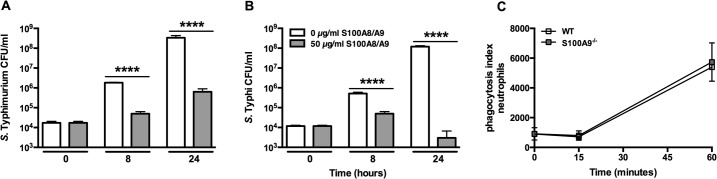
S100A8/A9 inhibits bacterial growth of S. Typhimurium and S. Typhi in vitro.Growth of S. Typhimurium (14028; A) and S. Typhi (Vivotif, Crucell; B) was assessed for a maximum of 24 hours in the presence of recombinant S100A8/A9 (50 μg/ml; grey bars) or control (white bars). Bacterial growth was dose dependently inhibited by S100A8/A9. Growth arrested, CFSE-labelled heat-inactivated S. Typhimurium bacteria were incubated with peripheral blood neutrophils (C) from wildtype (WT; white) and S100A9
-/- mice (grey) (n = 4 per mouse strain) for 0, 15 and 60 minutes respectively after which phagocytosis was quantified (see Methods). Data are expressed, as mean ± SD. **** P<0.0001, determined via non-parametric t tests comparing different dosages per time point.